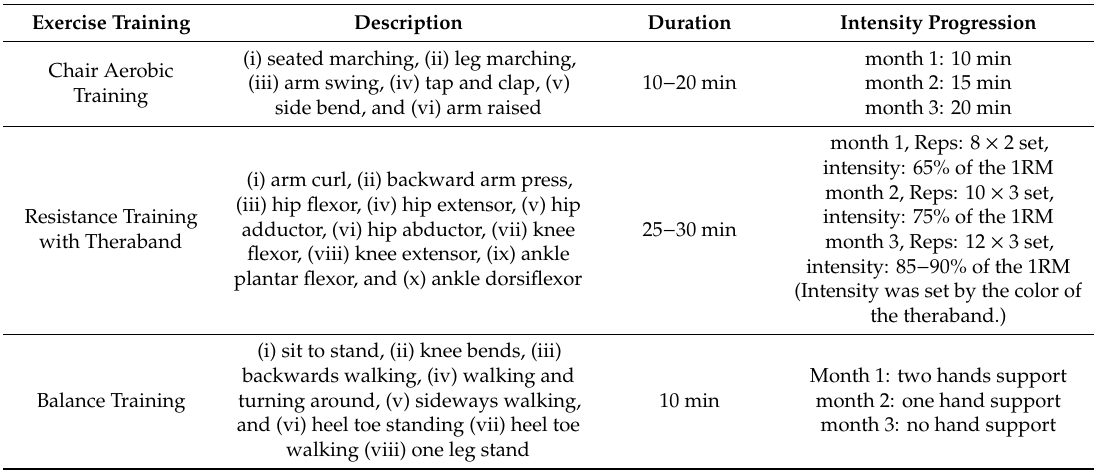
Table 1. Multicomponent exercise program